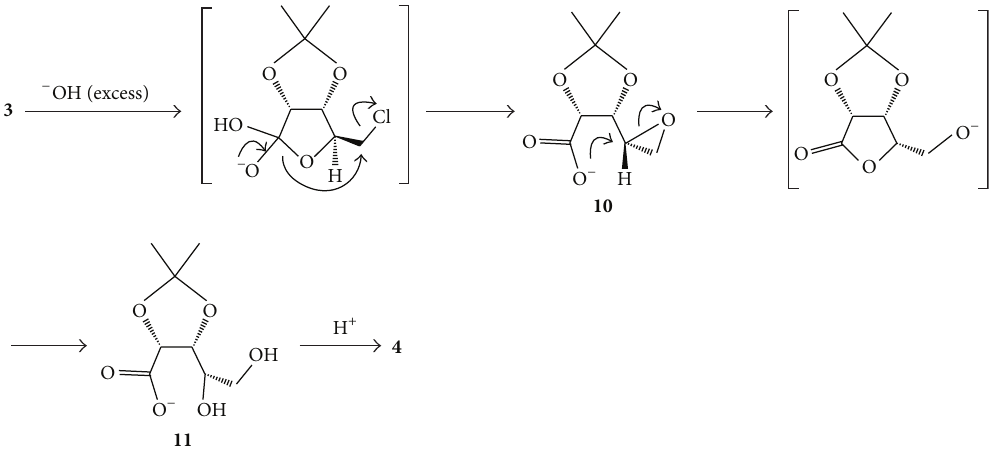
Scheme 2: Plausible reaction pathway for the configurational inversion at C-4 by base-promoted hydrolysis of lactone 3 .